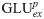
Free energy of major CLC-2 conformational states, projected onto all major dynamical modes (tICs), as a function of GLUex protonation.These landscapes are shown in both 1D and 2D, for both the deprotonated dataset (GLUex, black solid lines) and the protonated dataset (GLUexp, gray dashed lines). tIC 0 denotes the conformation of the S168-G169-I170 backbone, while tIC 1 and tIC 3 denote the conformation of the GLUex side chain. In all cases, Coi was found to be the global free energy minimum, and to not vary greatly with respect to GLUex protonation. Also insensitive to protonation are the basin free energies of Co and O. The largest difference caused by GLUex protonation is the existence of U, which occurs only for GLUexp (as isolated by tIC 1), and the structure of the kinetic barriers.